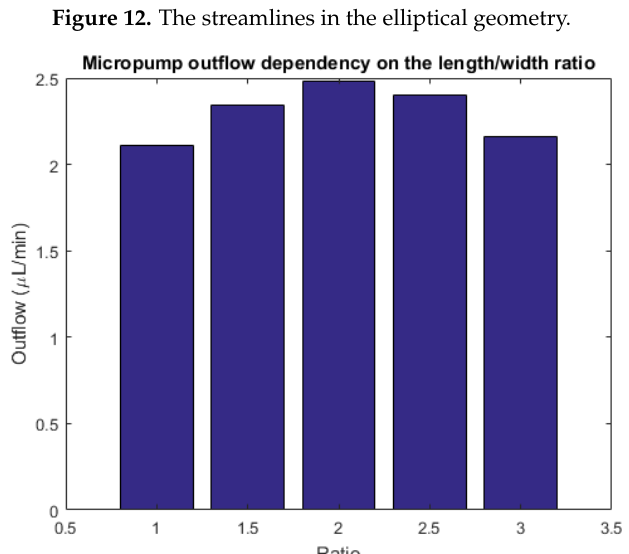
Figure 13. The outflow of the micropump for different length-to-width aspect ratios.